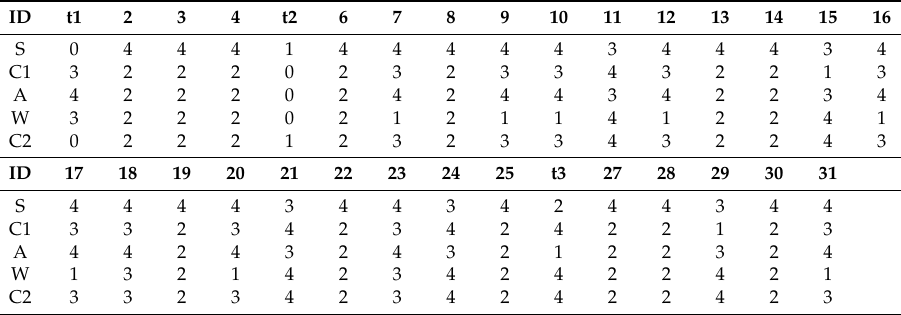
Table 4. The clustering result based on different linkage